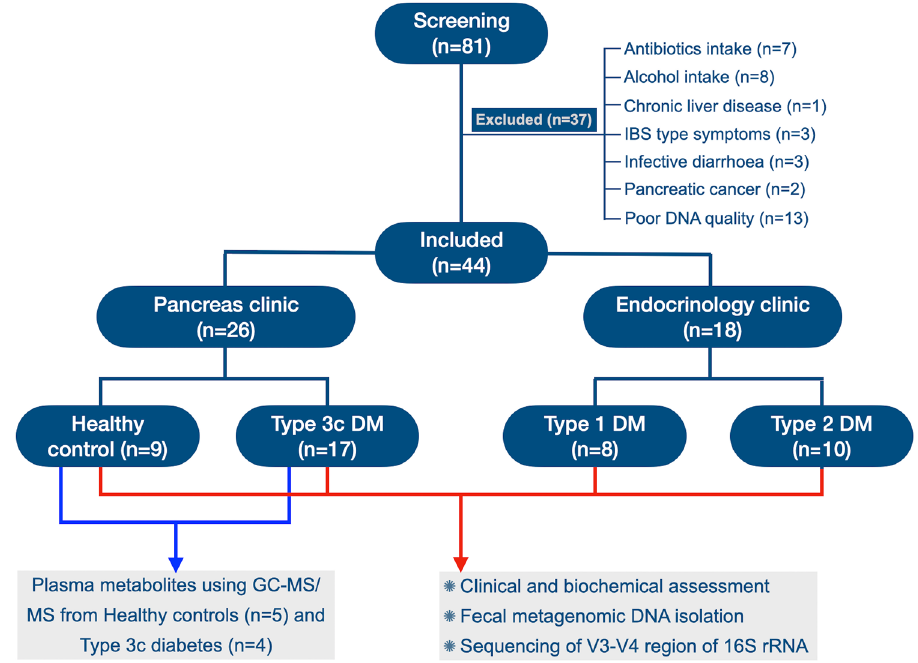
Figure 1. Study groups and patient